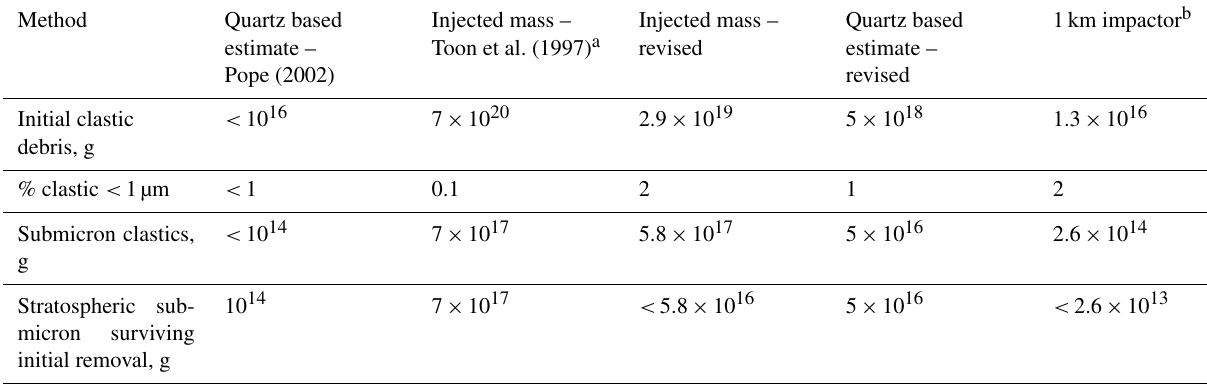
Table 5. Comparison of Toon et al. (1997) and Pope (2002) estimates of submicron clastics.